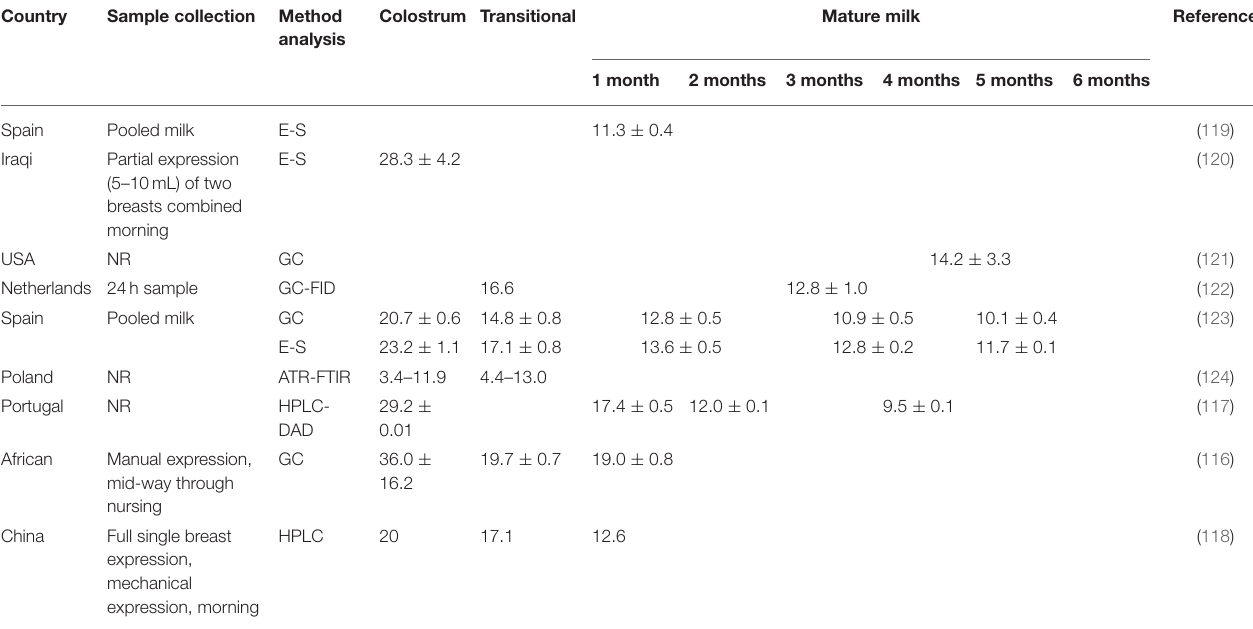
TABLE 4 | Concentration of cholesterol in human colostrum, transitional, and mature milks.